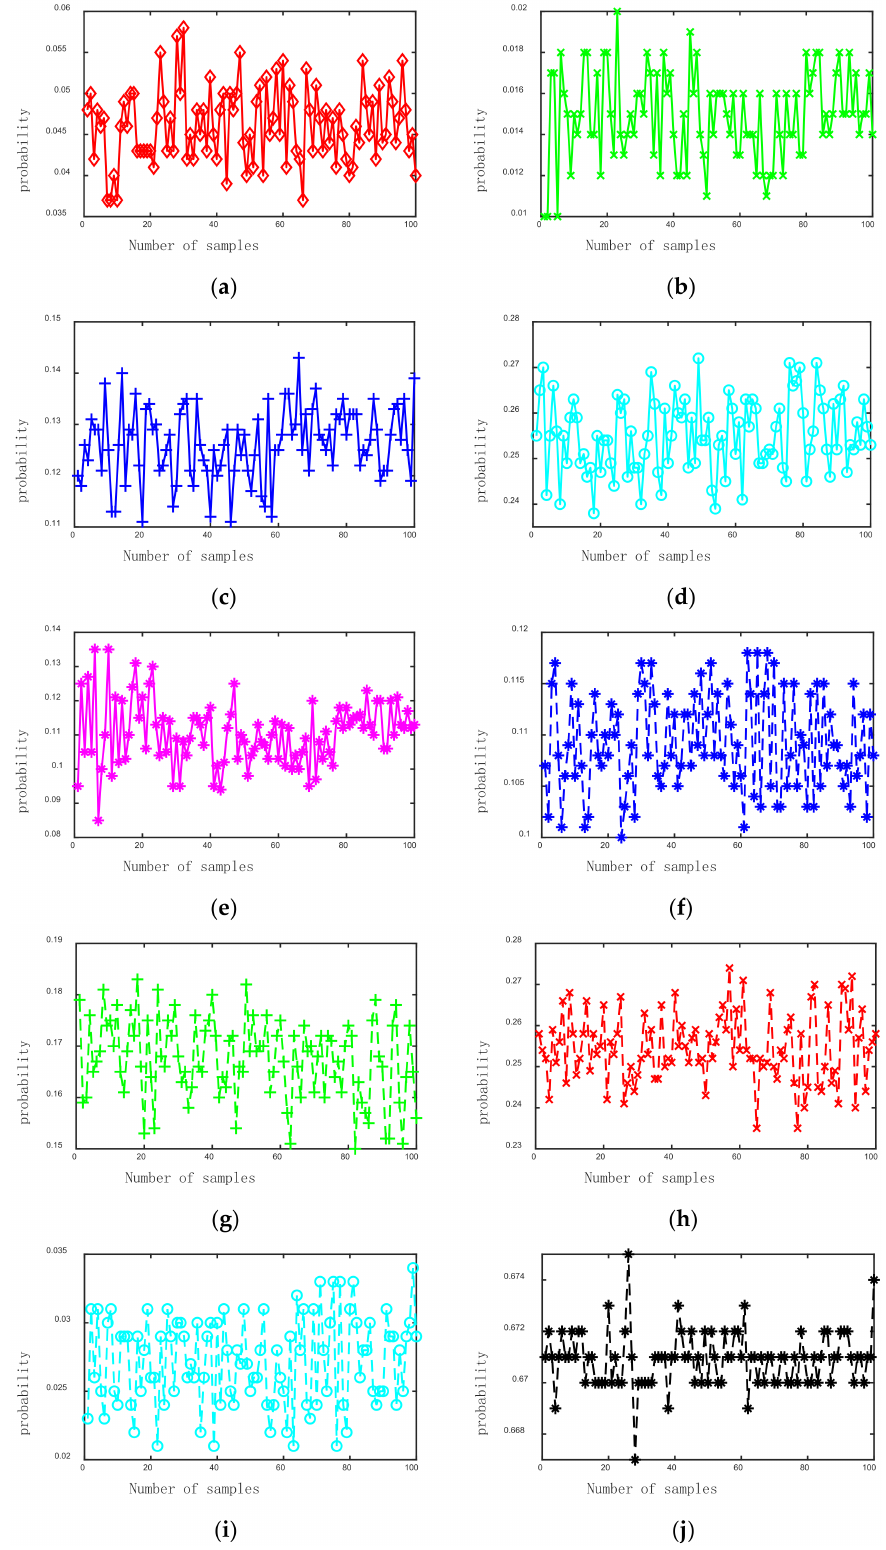
Figure 6. Experimental data. ( a ) Drive power failure; ( b ) The supply voltage is too low; ( c ) Motor encoder fault; ( d ) Bearing wear failure; ( e ) Demagnetization of rotor permanent magnet; ( f ) Weld detection sensor failure; ( g ) Welding gun suspension height sensor fault; ( h ) Control computer failure; ( i ) Setting error; ( j ) Incorrect setting of welding gun attitude and suspension